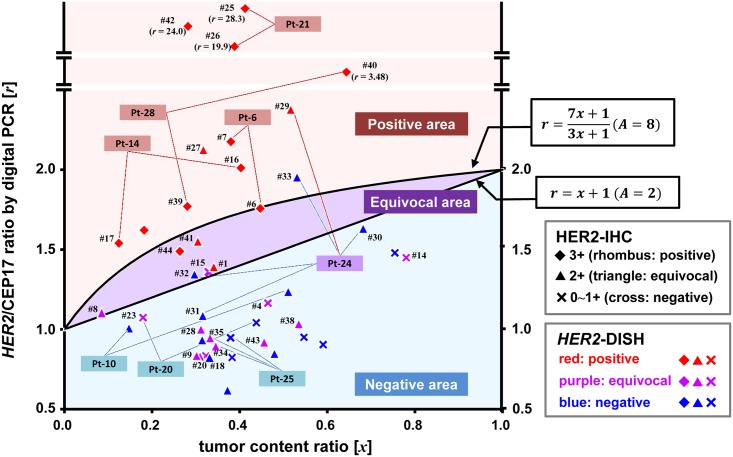
TC chart-assisted digital PCR analysis of clinical gastric cancer biopsy specimens.Each case was evaluated by HER2-IHC and digital PCR, and then validated by HER2-DISH (Table 3 and S1 Table). The results are plotted on the TC-chart. The findings of HER2-IHC are represented by symbols as follows; 3+ (positive) as rhombi; 2+ (equivocal) as triangles; 0~1+ (negative) as cross-mark. The results of HER2-DISH are depicted by colors as follows; positive, red; equivocal, purple; negative, blue. Multiple cases taken from the same patients (Pt) are highlighted. The vertical axis between 0.5 and 2.5 was linearly ordered and the upper area was logarithmically ordered. There were no positive cases (red rhombi) in the negative area, demonstrating that digital PCR can screen out negative cases with high specificity. On the other hand, cases plotted in the equivocal area were not always positive, as determined by CEP17 copy number. Three cases (#25, #26, and #42) showed markedly high scores and a clustering pattern in HER2-DISH (Fig 3C).